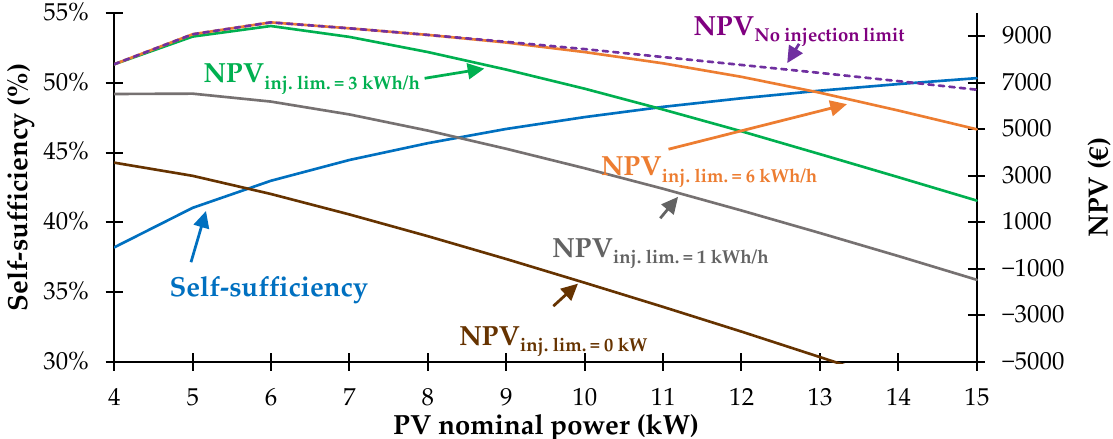
Figure 11. Self-sufficiency and NET Present Value ( NPV ) as functions of PV nominal power with different injection limits. In Table 3, the main results of the maximization of self-sufficiency or the economic return are summarized for a set of injection limits ( I.L. ) in the grid. In the first three columns, there are the PV nominal powers that maximize the self-sufficiency, with different injection limits (no limits, I.L. = 2 kWh/h, and I.L. = 0 kWh/h). In every case, the economic constraint IRR > 6% has to be respected. From the fourth to the sixth column, there are the results of the maximization of the NPV over 25 years with a discount rate of 3%, with the three different injection limits defined above. For example, to maximize the SS with an I.L. = 2 kWh/h, a PV plant with nominal power of 10 kW has to be installed; thus, the corresponding SS for this plant is 48%. Table 3. Main results of the reference